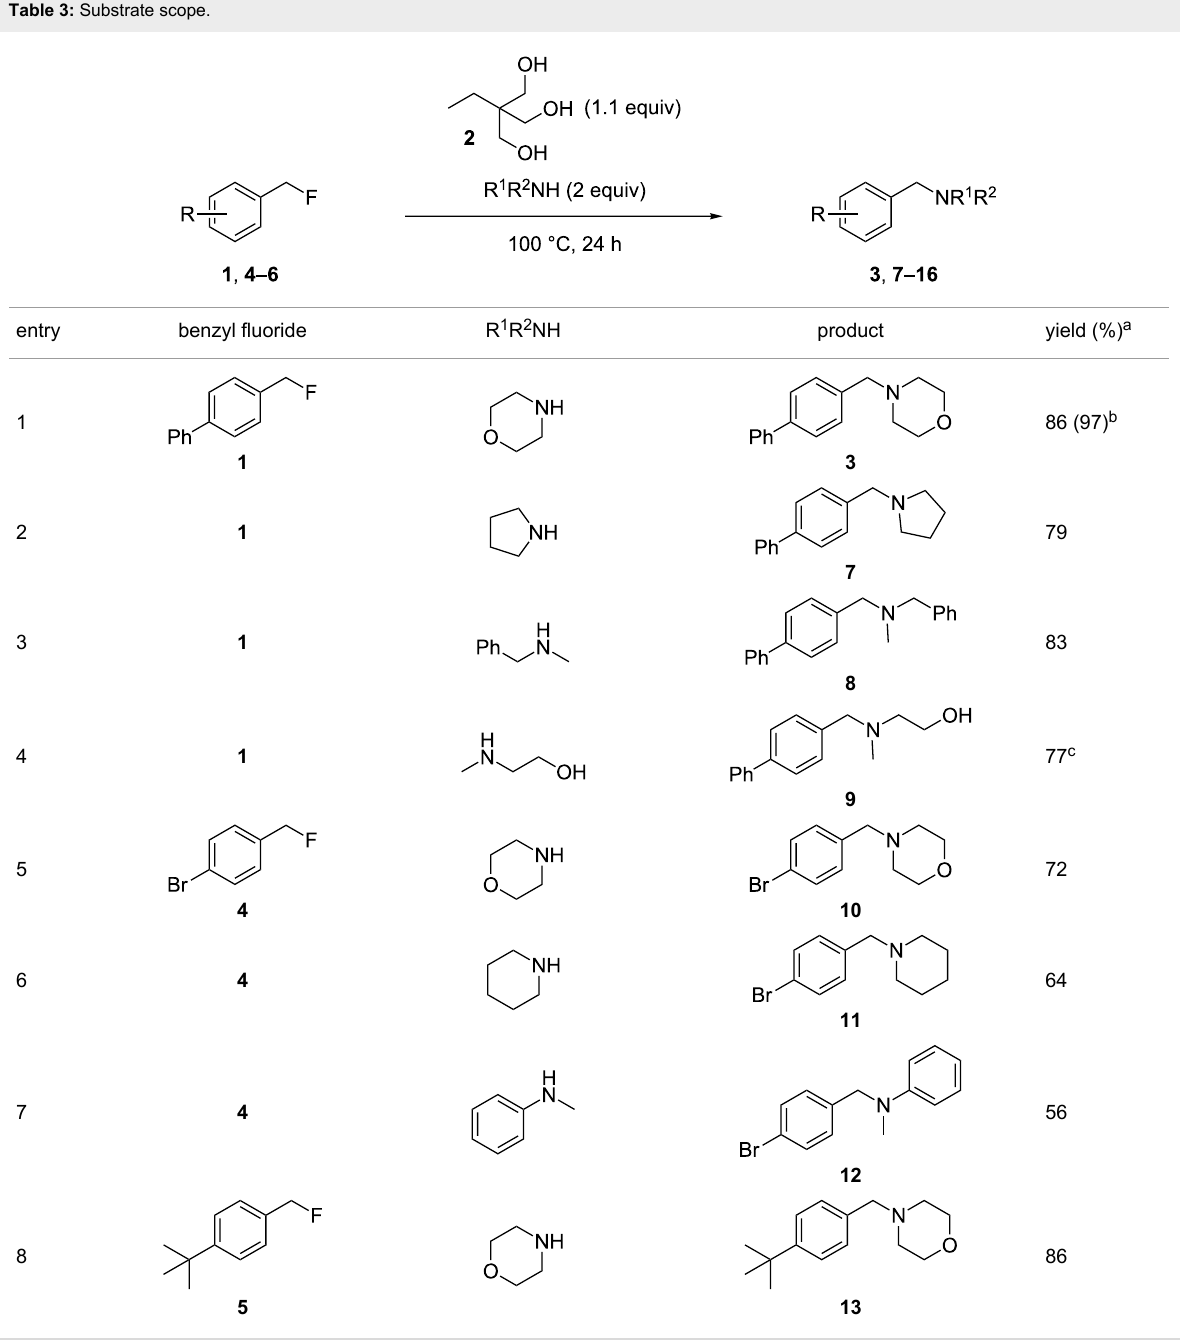
Table 3: Substrate